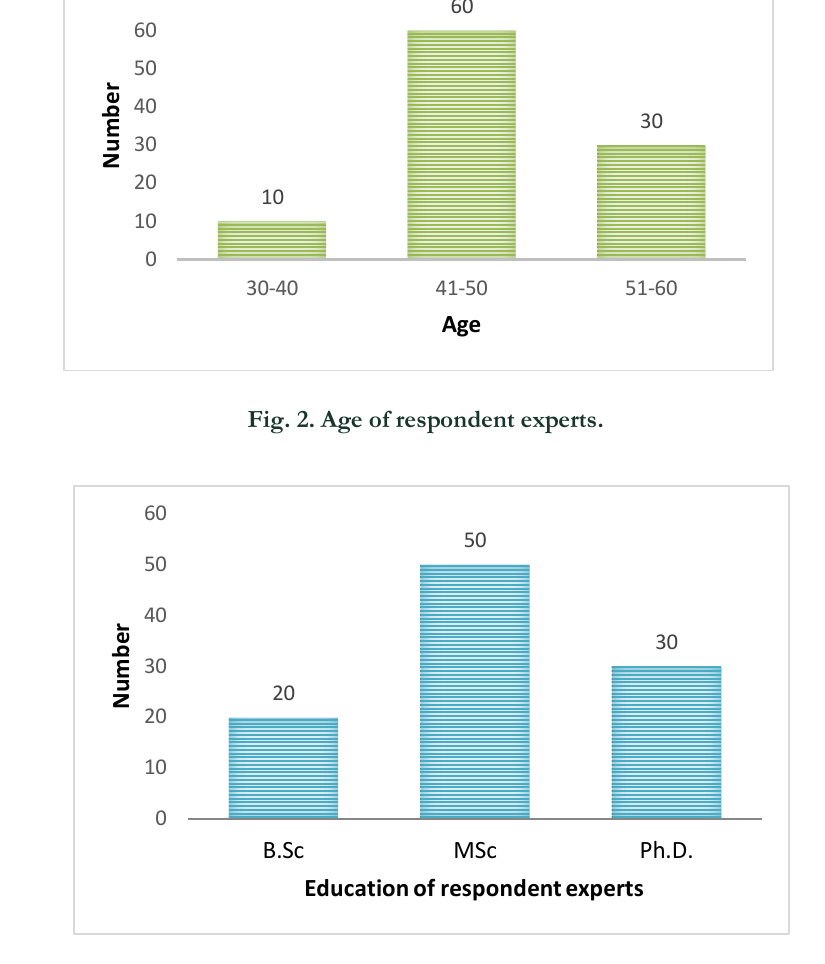
Fig. 3. Education of respondent